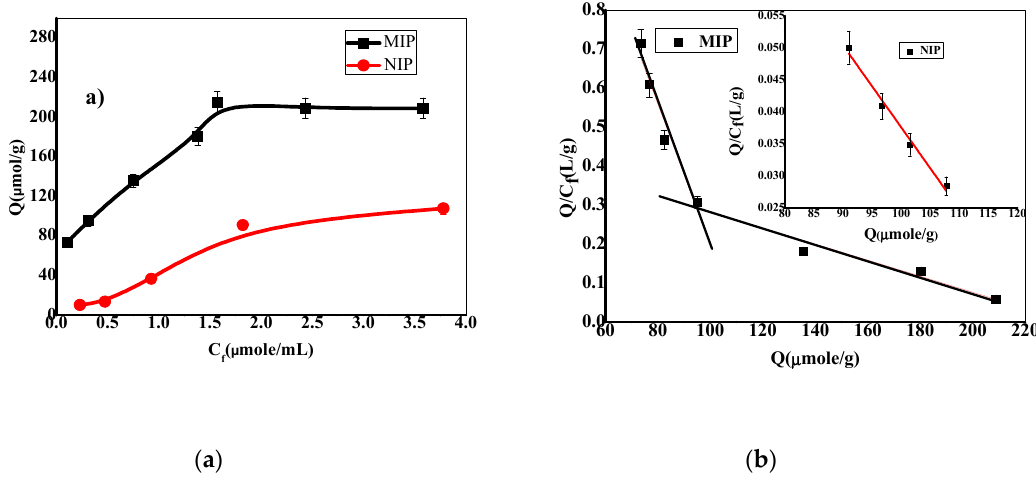
Figure 4. Binding isotherm ( a ) and Scatchard plot ( b ) for MIP and NIP.